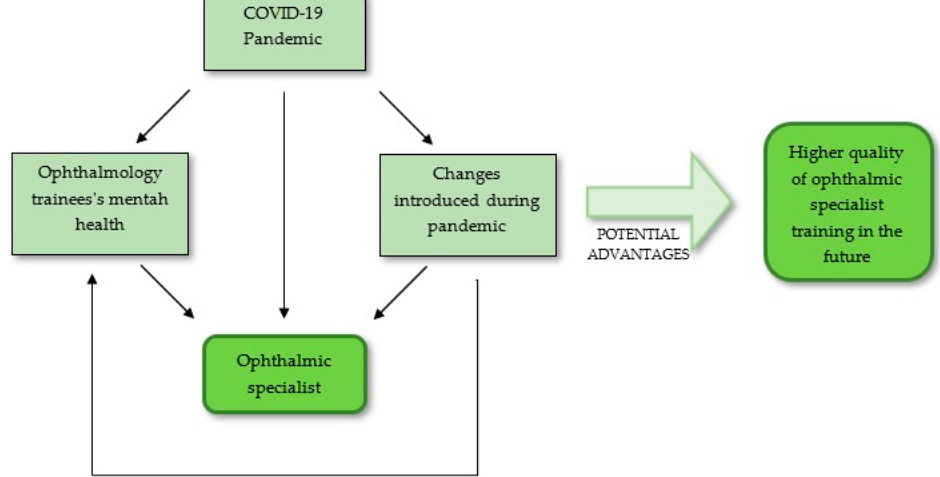
Figure 1. Diagram presenting the main idea of our study